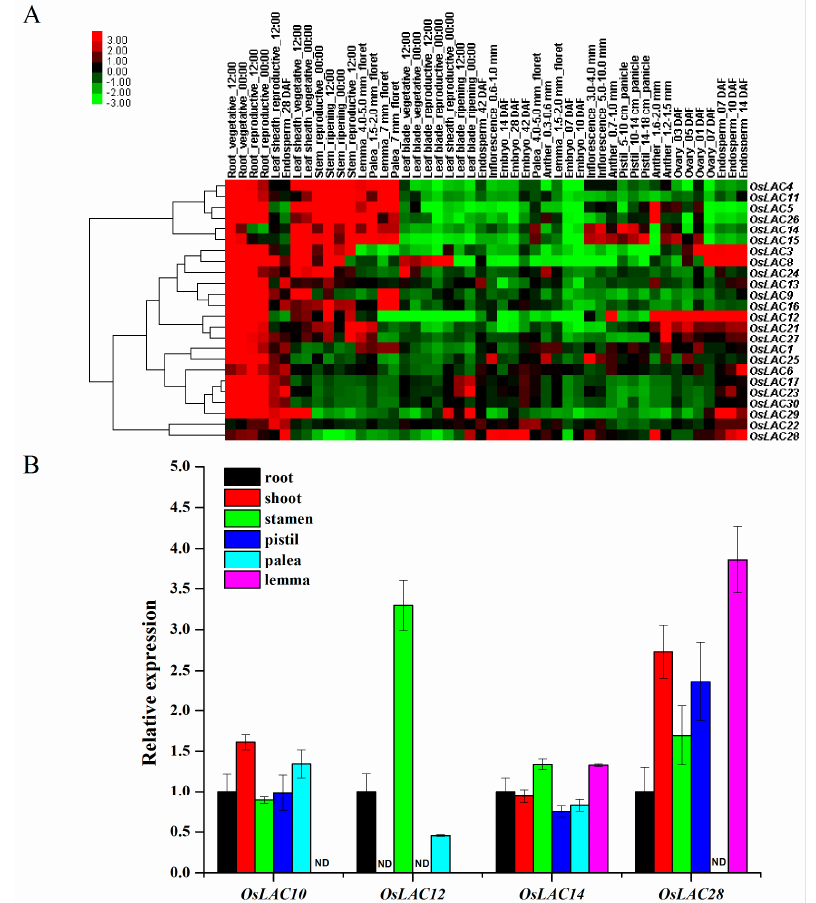
Figure 3. Expression patterns of rice laccase ( LAC ) genes in various tissues/organs and developmental stages. ( A ) Cluster heat map for spatiotemporal location of laccase genes expressions in various tissues/organs of rice. Normalized signal intensity of genes obtained from the RiceXPro database; ( B ) Real-time PCR analysis of selected genes to validate their differential expression during various stages of development. The mRNA levels for each gene in different tissue samples were calculated relative to its expression in root. The error bars represent standard deviation. ND, not detected. Abiotic stressors, including hormones, salt, drought, and toxic heavy metals (Cr, Cd, As, Pb) induced the expression of rice laccase genes. OsLAC19 was significantly up-regulated under the